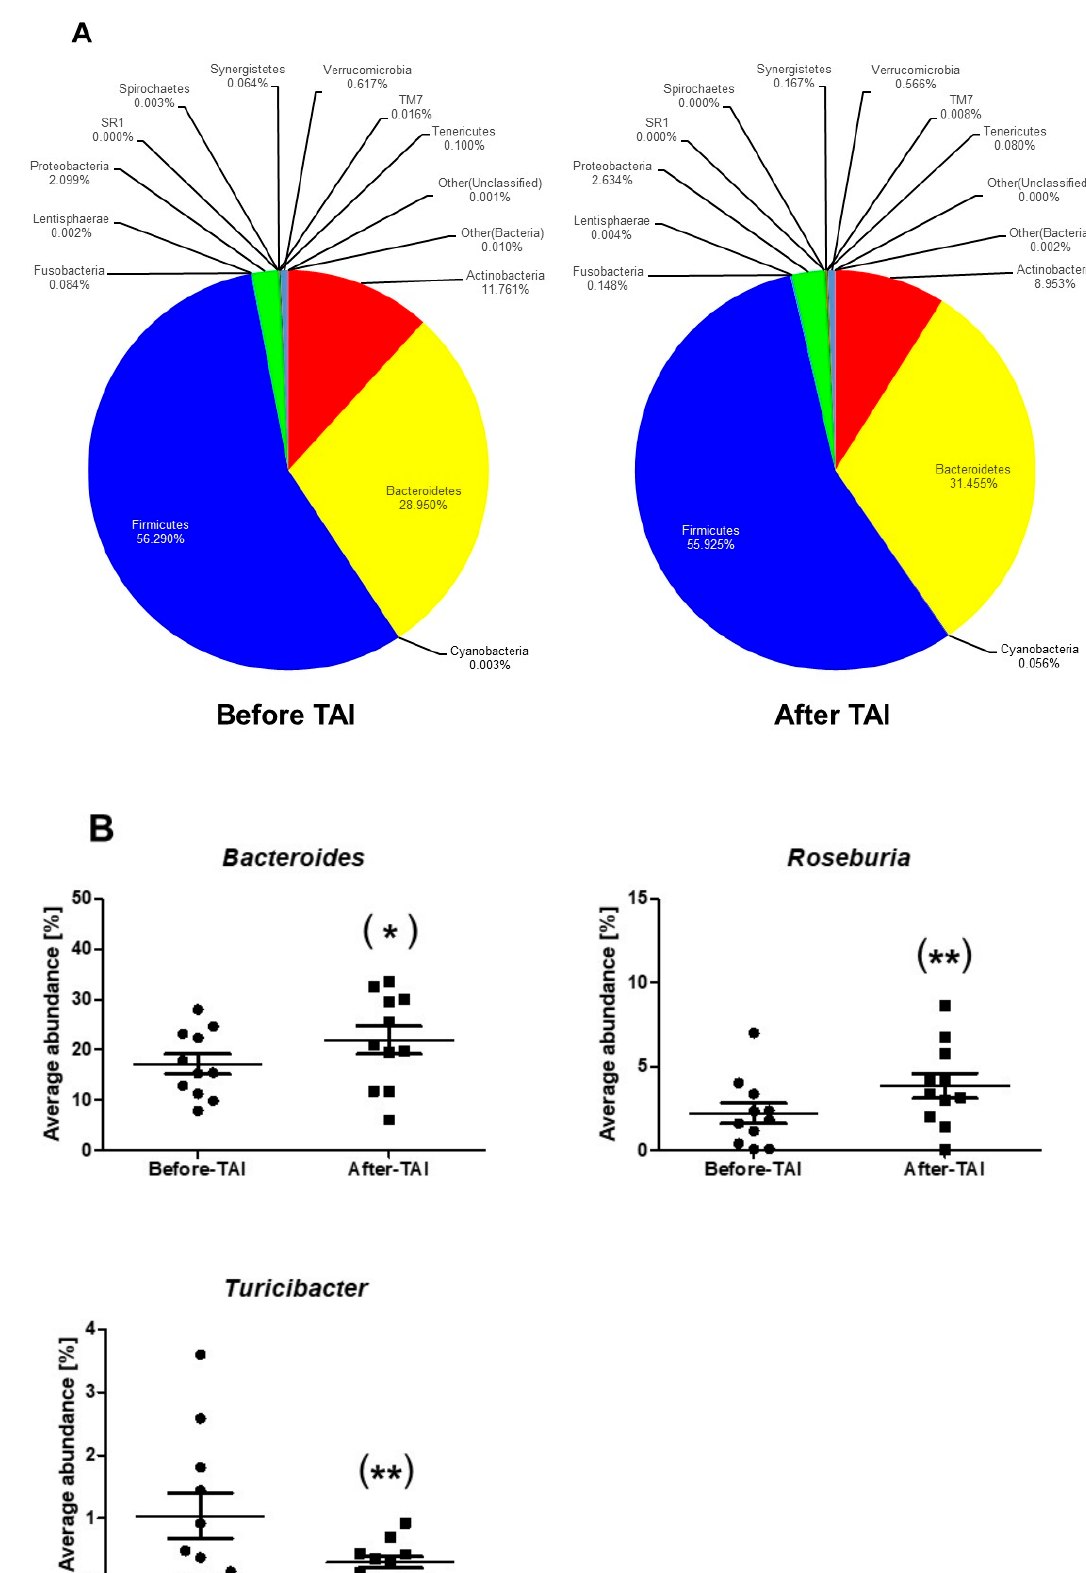
Figure 2. Changes in gut microbiota after TAI in the SB patients at the phylum level ( A ) and the genus level ( B ). *; p < 0.05, **; p < 0.01 vs. before TAI. Table 4. Changes in gut microbiota after TAI in the SB patients.